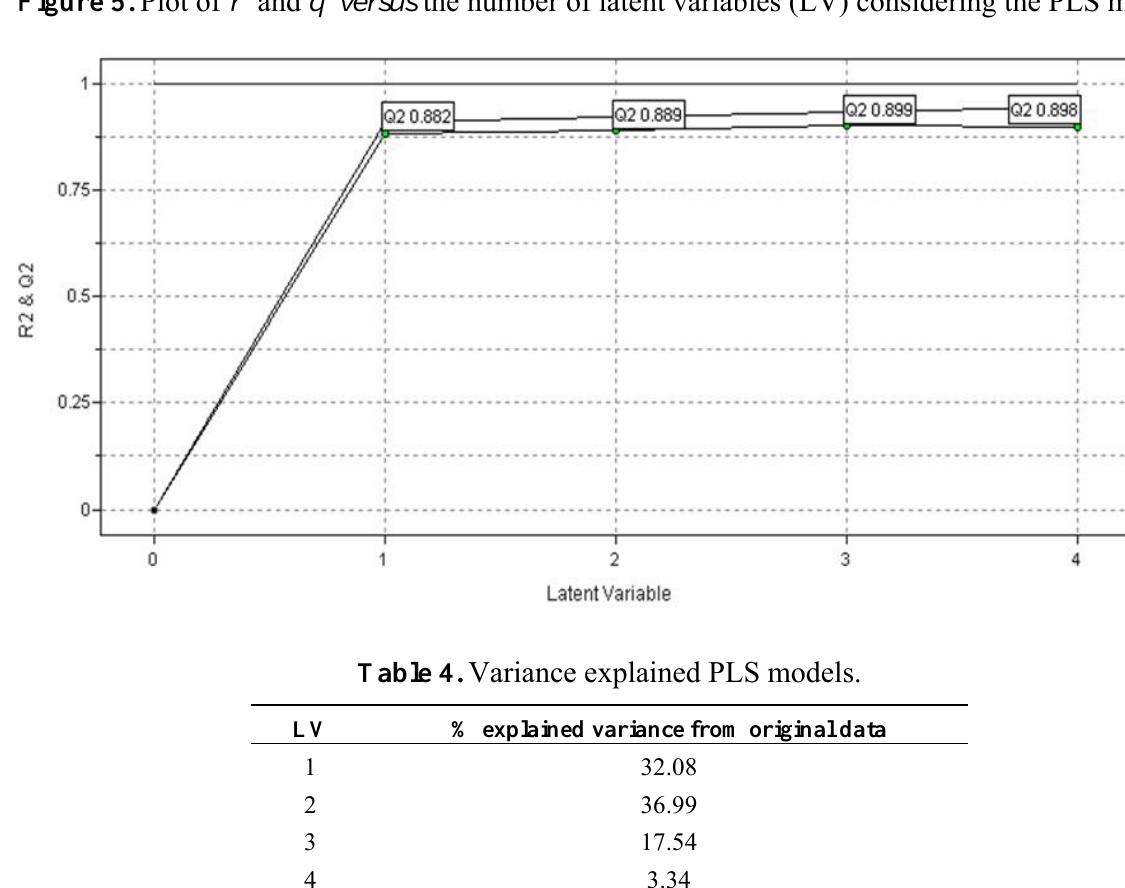
Figure 5. Plot of r 2 and q 2 versus the number of latent variables (LV) considering the PLS models.